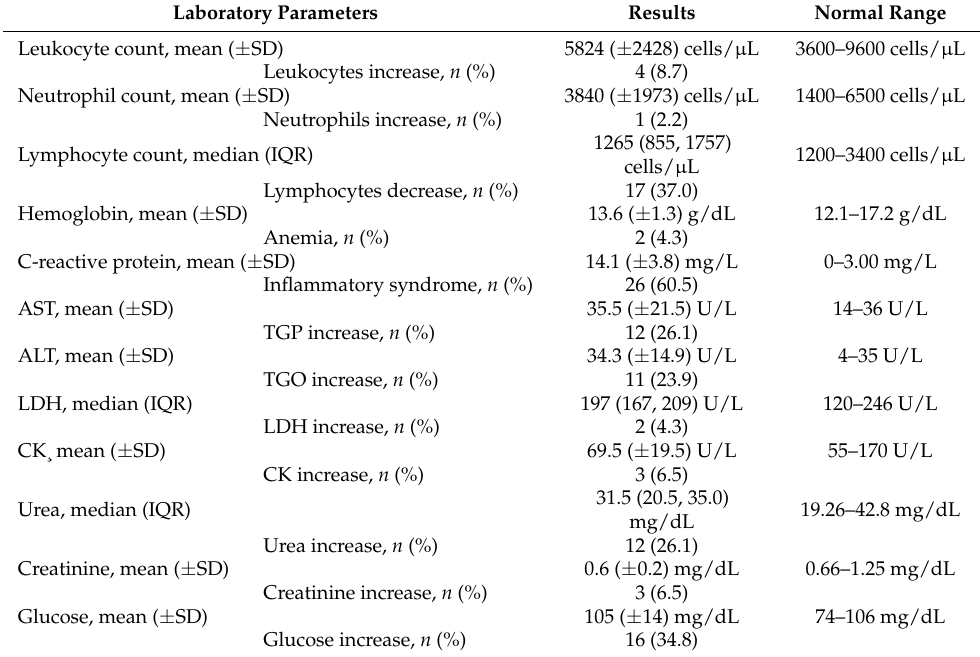
Table 3. Baseline laboratory